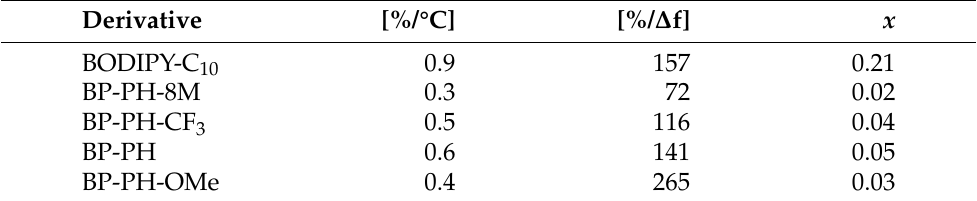
Table 2. The relative sensitivities to temperature, polarity, and Förster–Hoffmann constant x showing the extent of viscosity sensitivity of BODIPY-C 10 , BP-PH-8M, BP-PH-CF 3 , BP-PH, and